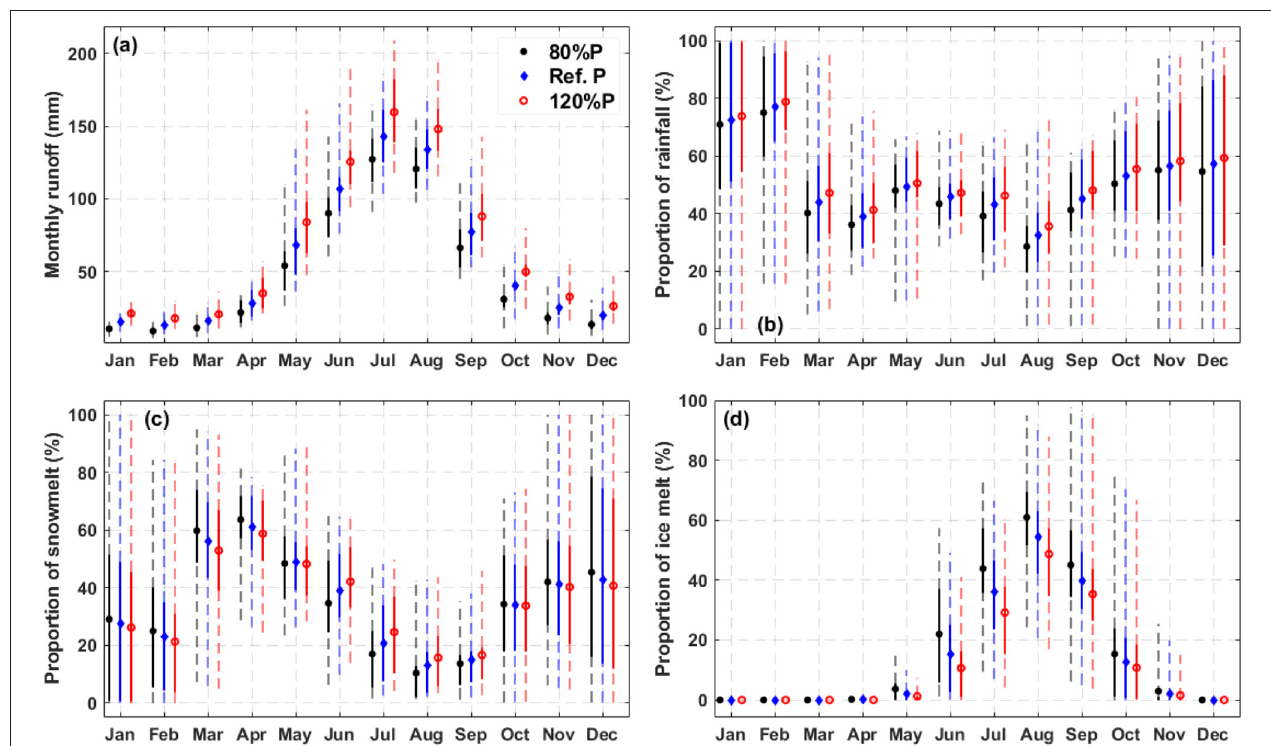
FIGURE 7 | Responses of monthly runoff and proportions of water inputs to precipitation changes. Boxplots indicate the inter-annual variabilities during the 20-year modeling period, and dots indicate mean values during the modeling period. (a) for the comparisons of monthly runoff simulations, (b–d) for proportions of rainfall, snowmelt and ice melt in the total water